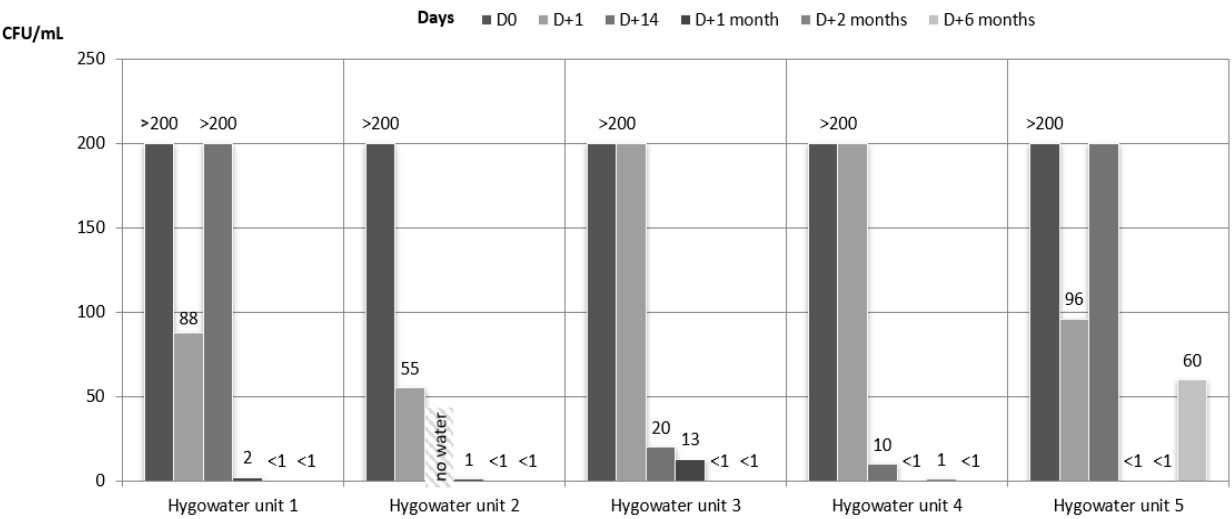
Figure 3. Microbiological quality of the water samples for the units connected to the Hygowater ® system. HPC at 22 °C.